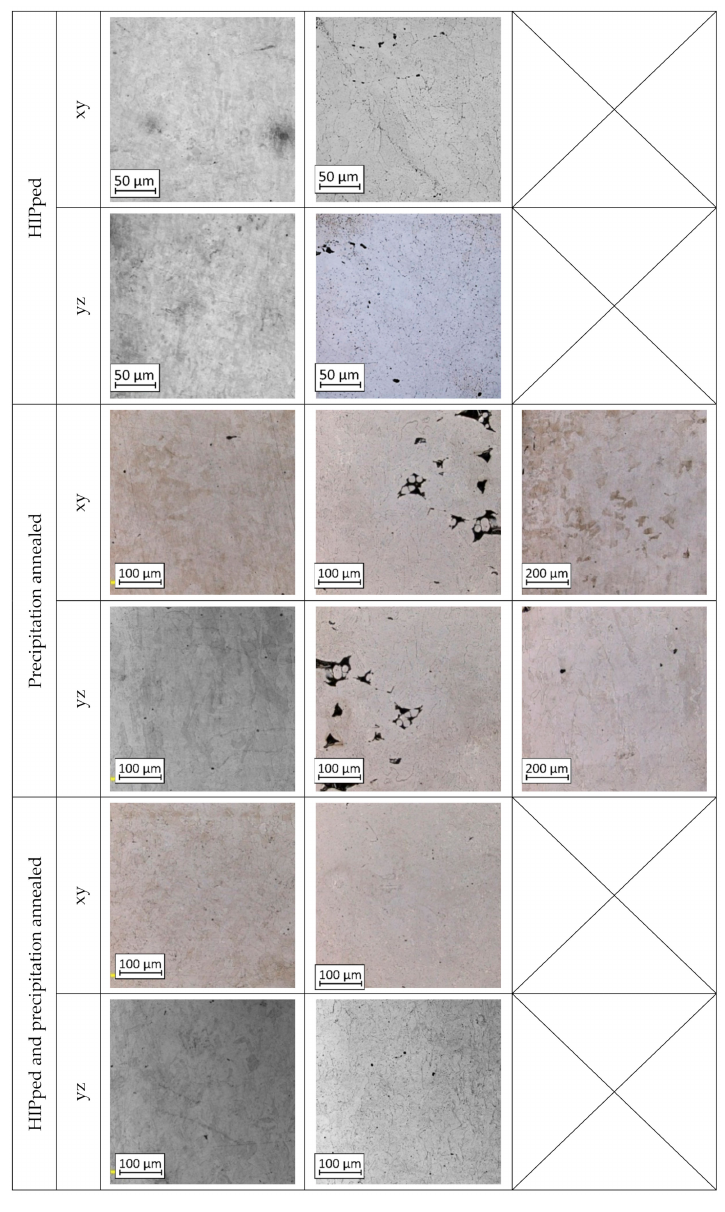
Figure 9. The microstructure of S_01, S_17 and S_30 samples heat-treated using di ff erent processes and their combinations